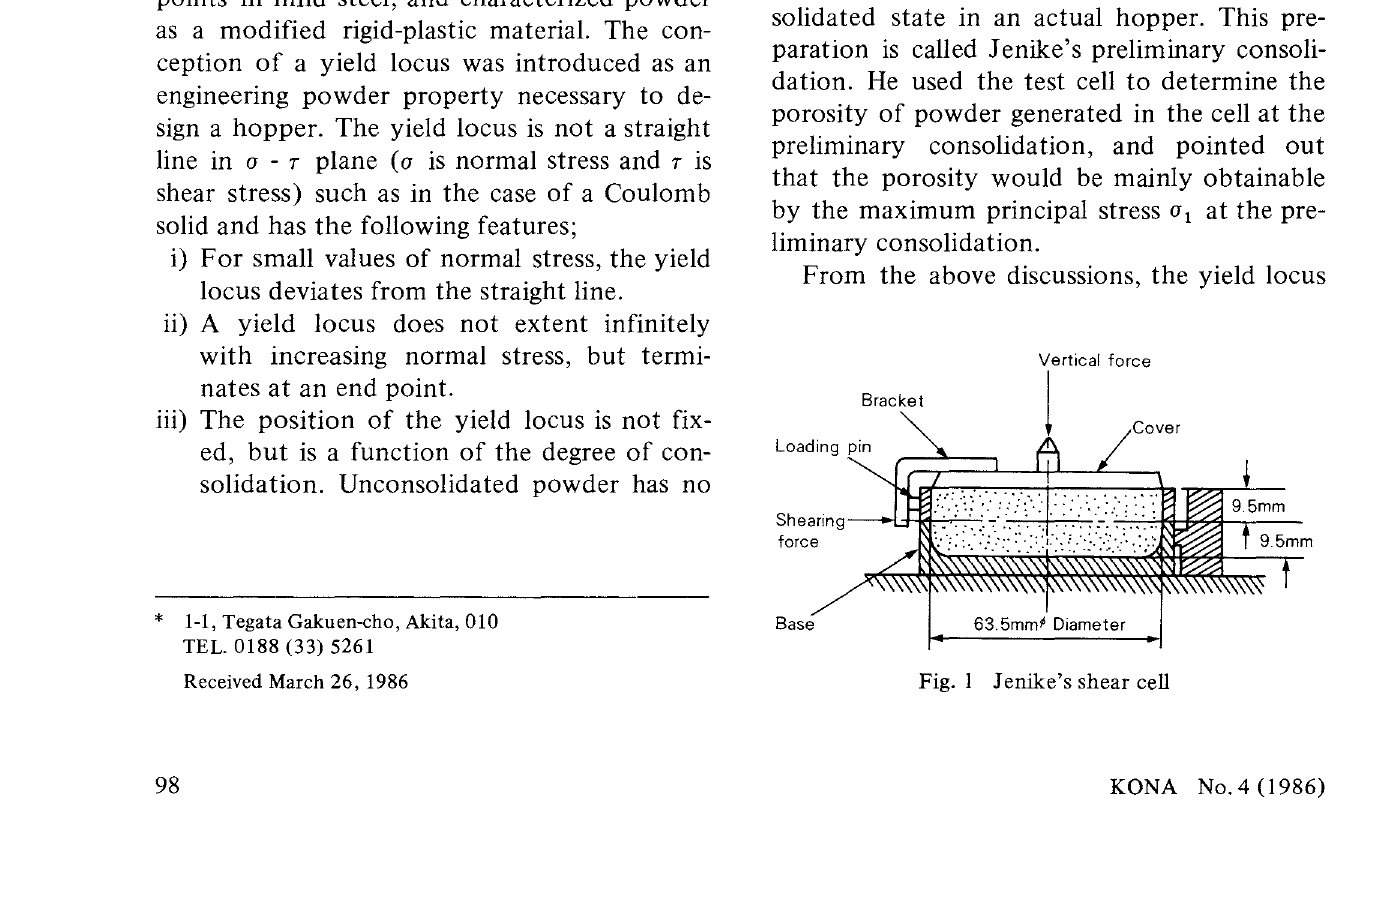
Fig. 1 J enike's shear